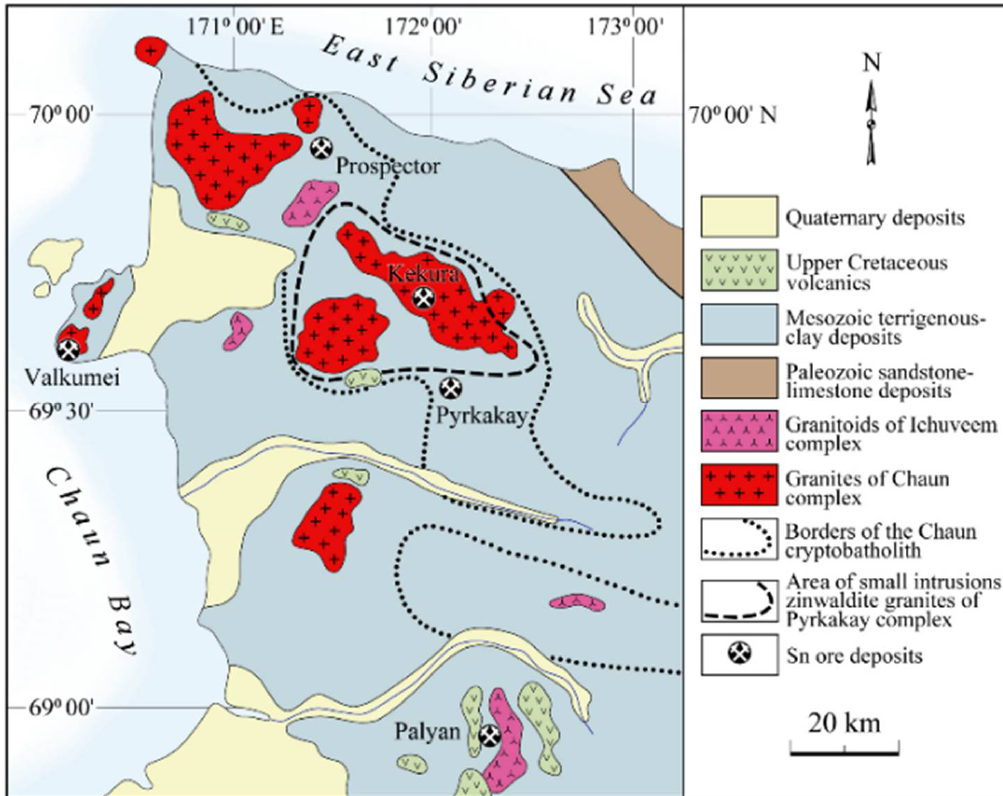
Figure 6. Simplified geologic map showing the distribution of late Mesozoic magmatic bodies and tin ore deposits in Chaun ore district, Chukotka, the Russian Northeast (modified from Alekseev and Alekseev [35]).